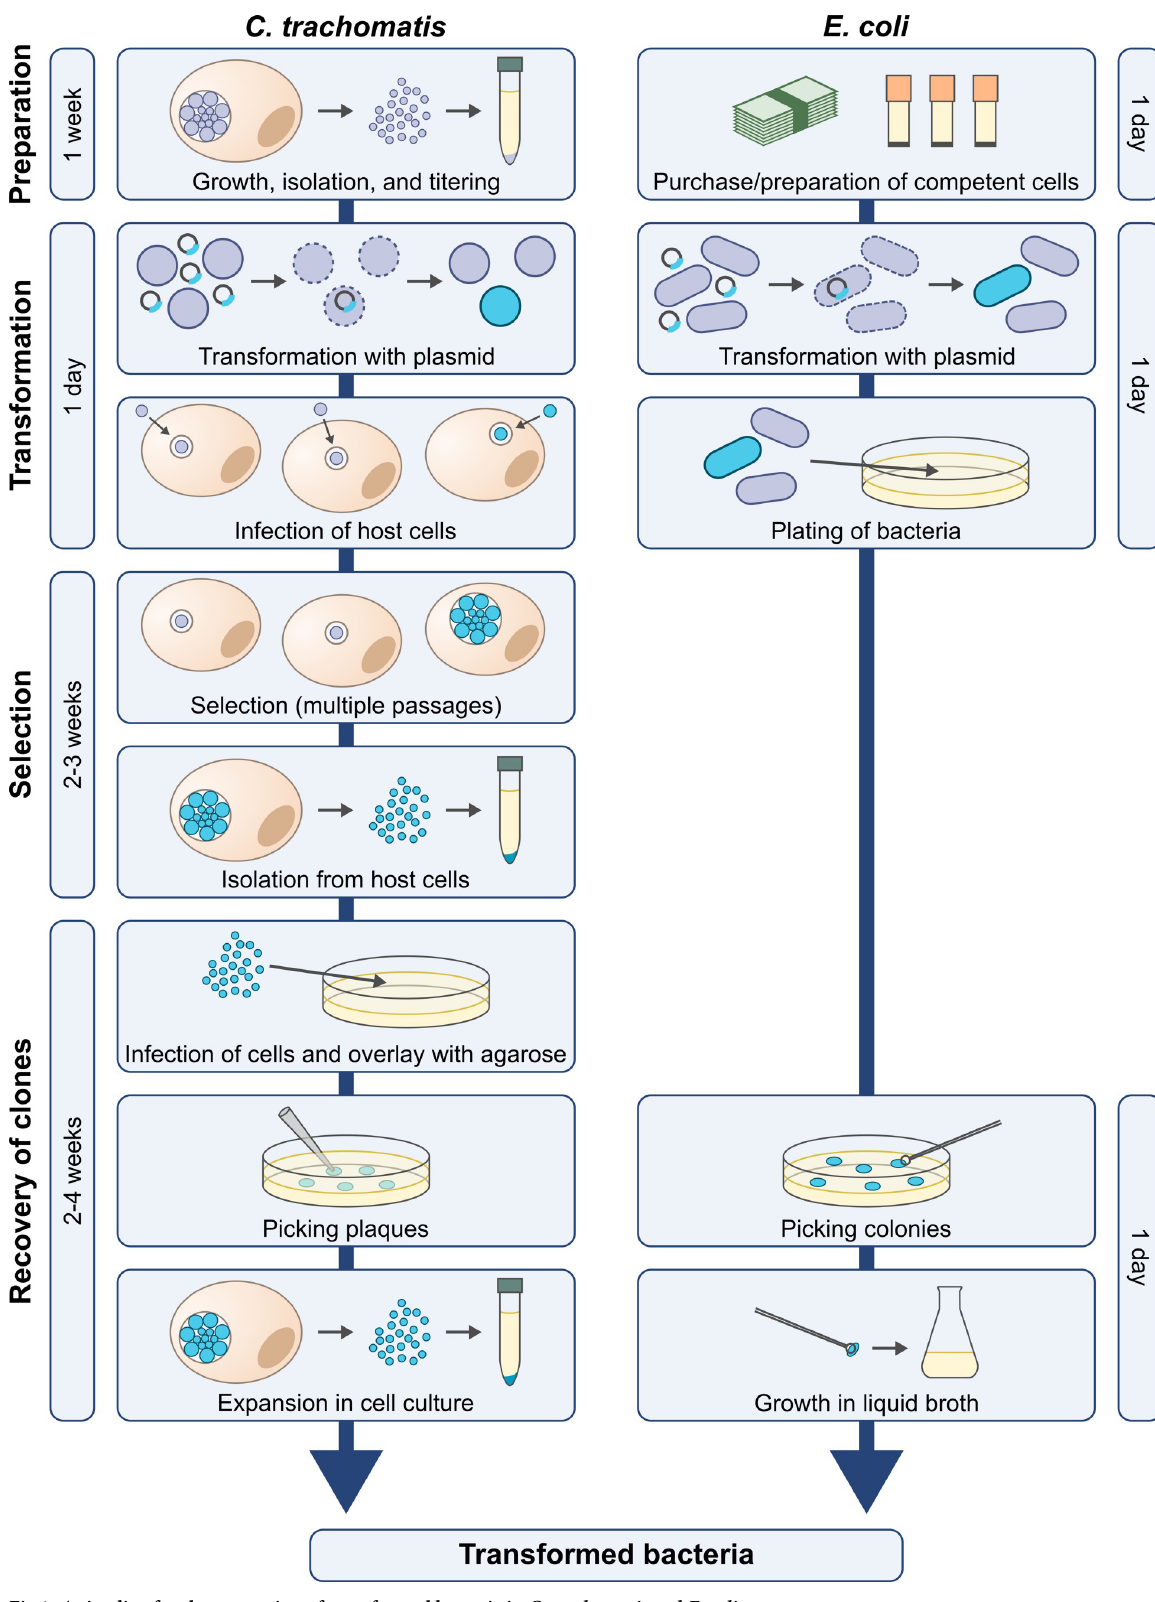
Fig 1. A timeline for the generation of transformed bacteria in C . trachomatis and E . coli . https://doi.org/10.1371/journal.ppat.1010669.g001 PLOS Pathogens| https://doi.org/10.1371/journal.ppat.1010669 July 28,